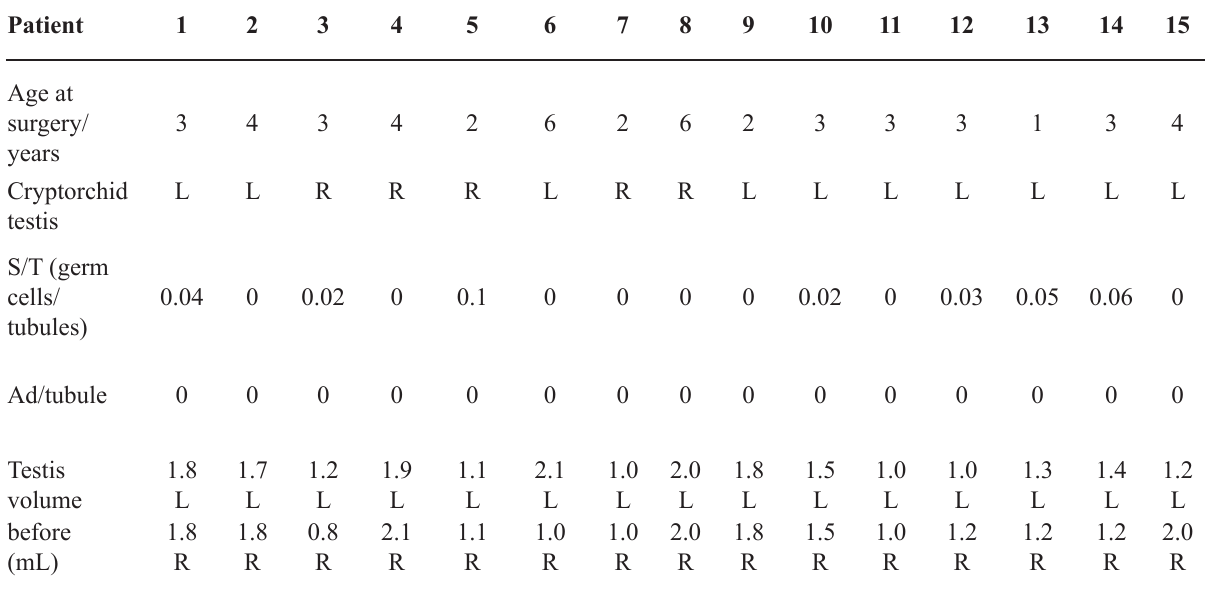
Table 1 – Characteristics of the 15 patients with cryptorchidism immediately before and after treatment with luteinizing hormone releasing hormone.